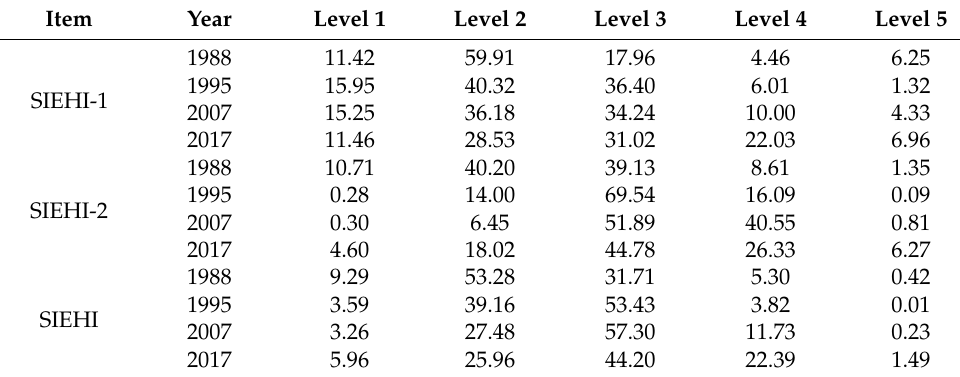
Table 4. Proportions of different levels of the sandy island ecosystem health (%).